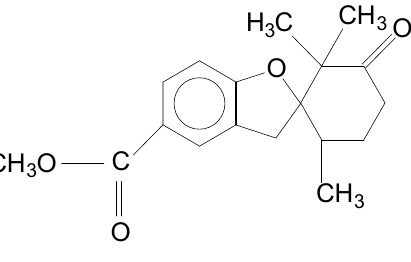
Figure 1. Filifolinone structure.